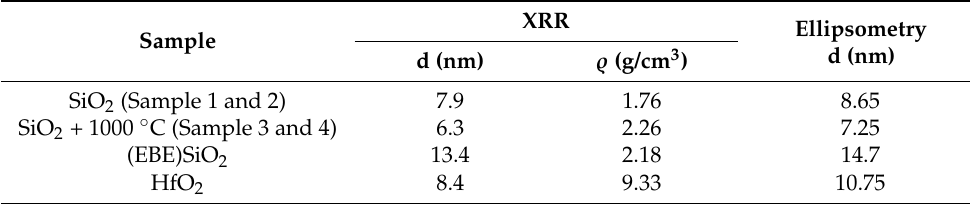
Table 2. Thickness, density, and refraction indexes of the studied dielectrics on Si/TiN substrates, estimated by XRR and ellipsometry methods. The ellipsometric thickness of (EBE)SiO 2 was obtained using the predefined dispersion values, with the refractive index at 633 nm as